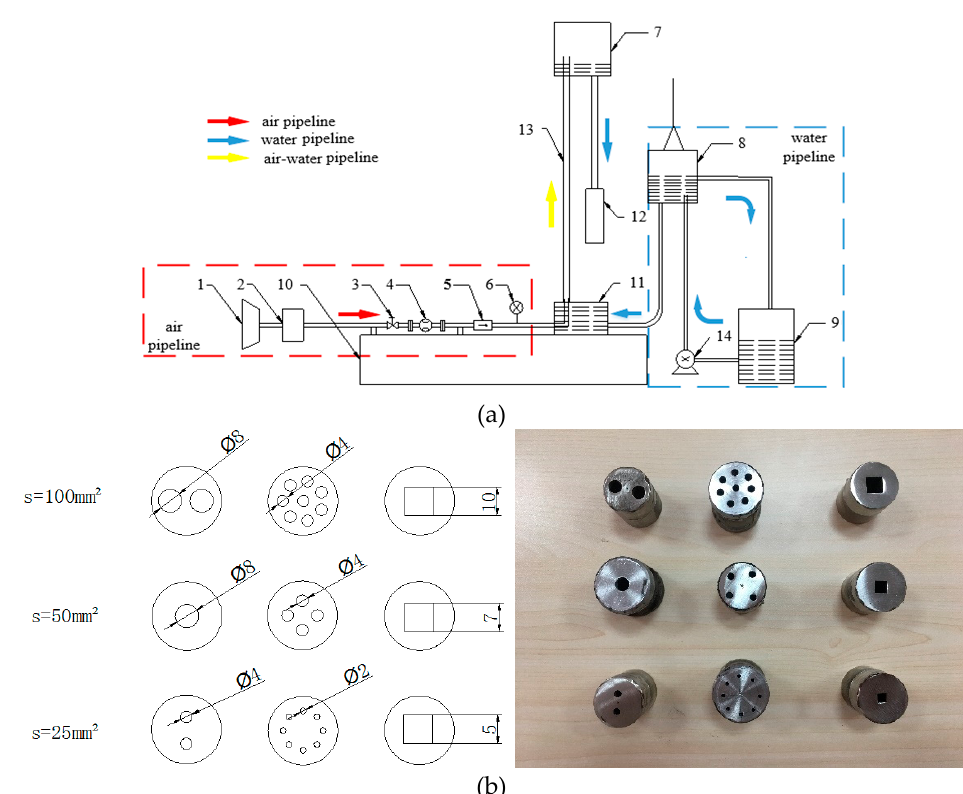
Figure 1. Experimental device of a pneumatic lifting pump. ( a ) The experimental overall frame: 1. air compressor, 2. dryer, 3. needle valve, 4. flowmeter, 5. check valve, 6. pressure gauge, 7. gas-liquid separator, 8. level control box, 9. storage tank ,10. base, 11. nozzle, 12. measurement tank, 13. riser, 14. water pump. ( b ) Diagram of nozzles with three different inlet areas.